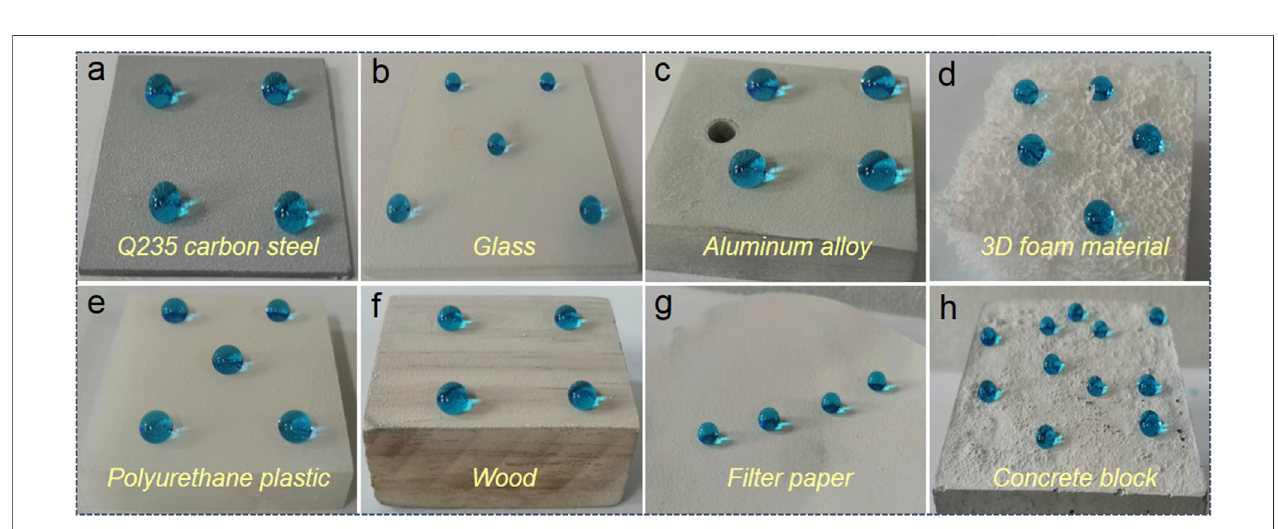
FIGURE 8 | Optical images of superhydrophobic Al 2 O 3 @PDMS coating on different substrates including (A) Q235 carbon steel, (B) glass, (C) aluminum alloy, (D) 3D foam material, (E) polyurethane plastic, (F) wood, (G) fi lter paper, and (H) concrete block.